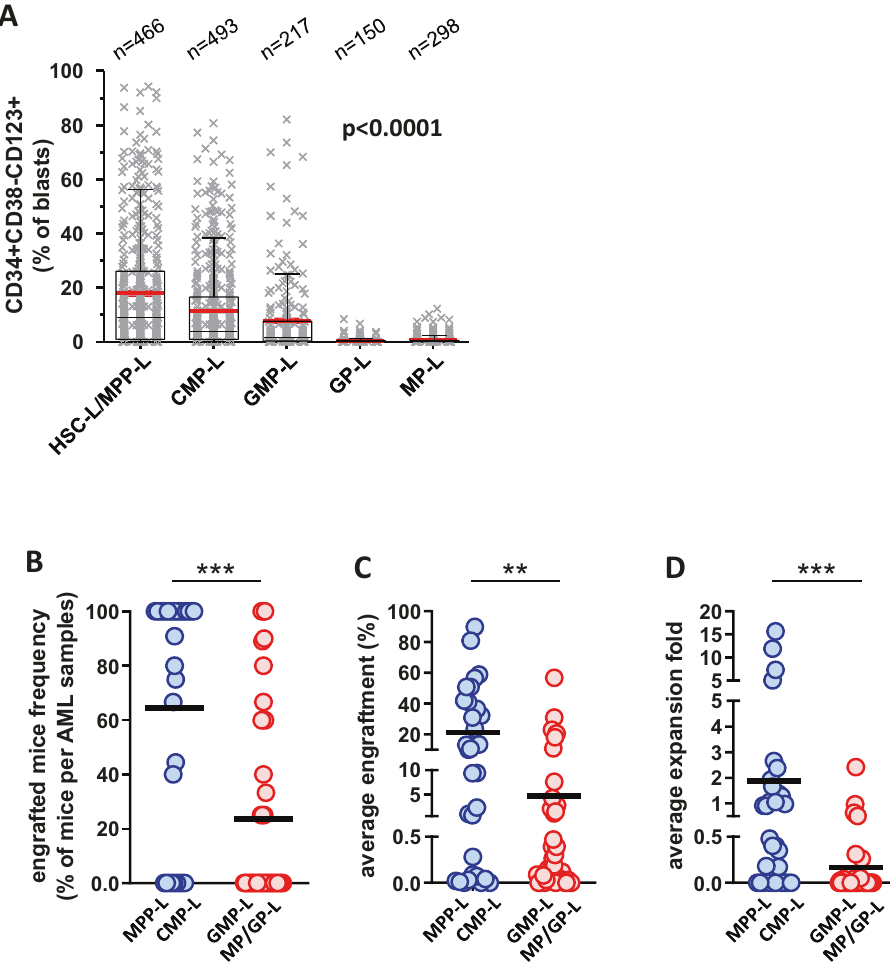
Fig. 3 Stem cell properties are related to the SLA. A Percentage of leukemic stem cells (CD34 + CD38 − CD123 + ) among blasts according to SLA in the TUH cohort (Kruskal – Wallis test). B – D Patient-derived xenograft from 70 AML patient samples in 446 mice. A group of fi ve mice is classically used to test an AML sample with an injected dose of 10 7 cells per mouse. Engraftment is assessed in a delay of 16 weeks. B Percentage of mice with >0.5% of human leukemic cells detected in bone marrow samples by fl ow cytometry. C Evaluation of human leukemic engraftment in bone marrow samples of each experiment. Each point represents the mean of all PDX of a donor. D Expansion fold is calculated as a ratio between engrafted cells in mice bone marrow and spleen and injected leukemic MP-L and GP-L are the two sides of NPM1 mutated AML MP-L and GP-L are phenotypically de fi ned as CD34 − AML, positive for myeloid markers (CD13 + CD33 + CD117 + / − ); and differ by their expression of HLA-DR ( ≥ 20% for MP-L and <20% for GP-L). Both groups frequently expressed NPM1 mutation (MP-L RR:3.8, p < 0.0001; GP-L RR:6.0, p < 0.0001, Fig. 4C). However, NPM1 mutations were associated with mutations of DNMT3A (RR:2.3, p < 0.0001) and FLT3 (RR:2.1, p < 0.0001) in MP-L, and with TET2 mutations in GP-L, (RR:4.6, p < 0.0001). Mutations in TET2 , IDH1 , and IDH2 are largely mutually exclusive and lead to similar epigenetic changes [38]. Since the TET2 mutations were enriched in GP-L, we looked at the distribution of IDH1 and IDH2 mutations in the TUH cohort and found that these mutations were also enriched in GP-L (Supplemental Fig. 4B). Indeed, the GP-L subgroup was composed of NPM1 / TET2 mutated and NPM1/IDH1 or NPM1/IDH2 mutated patients (52% and 20% of GP-L, respectively). Of note, besides the NPM1 -mutated MP-L subset which accounts for 64% of all MP-L and 82% of normal karyotype MP-L, MLL fusions were enriched in this SLA (RR:2.4, p < 0.0001; Fig. 4B) although their frequency is modest (59 patients in TUH cohort including 32 MP-L).